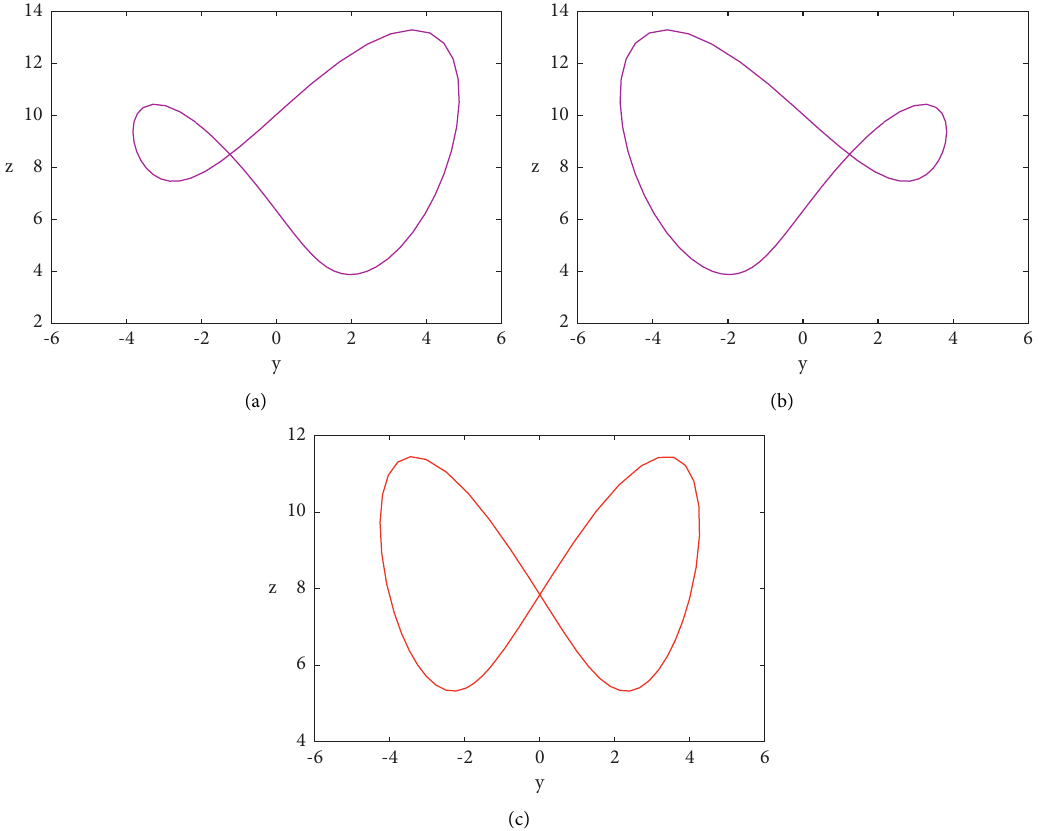
Figure 11: (a) Stable periodic orbit 03, (b) stable periodic orbit 12, and (c) unstable periodic orbit 01 in the Rucklidge chaotic system for ( a,b ) � ( 1 . 1 , 6 . 7 )